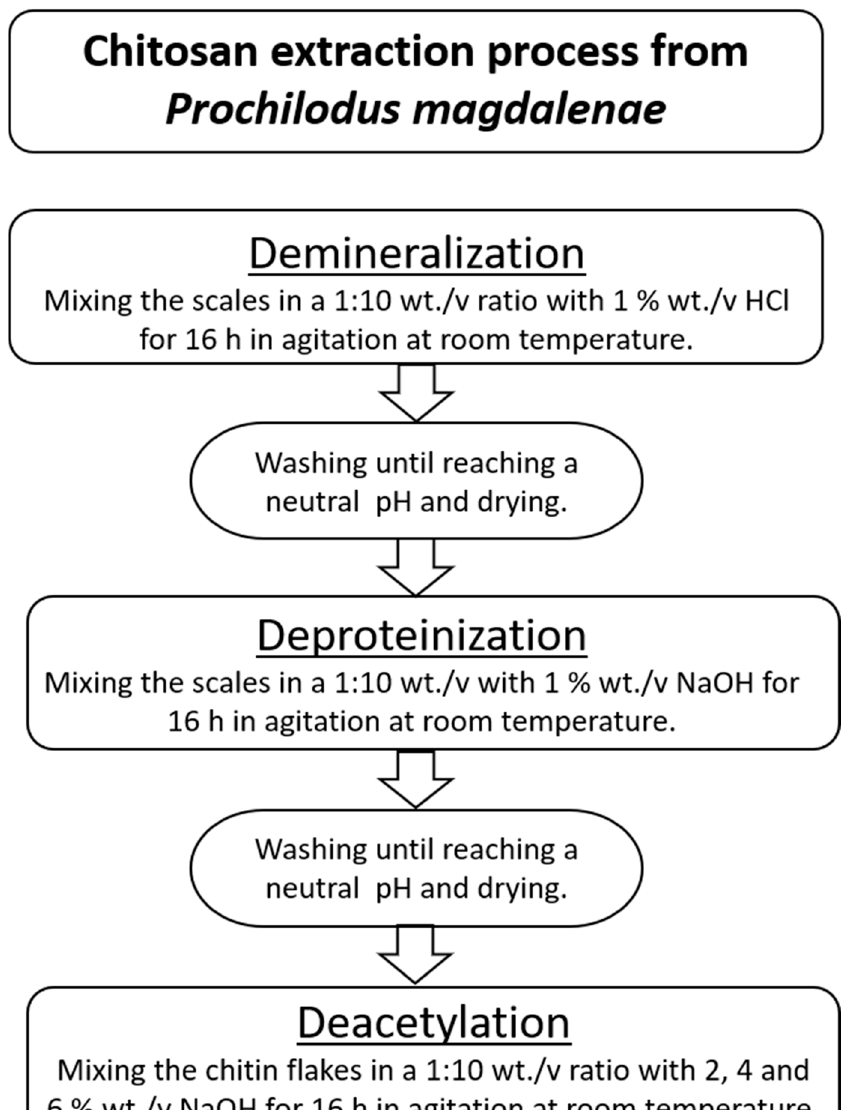
Figure 2. Chitosan extraction process from P. magdalenae scales.